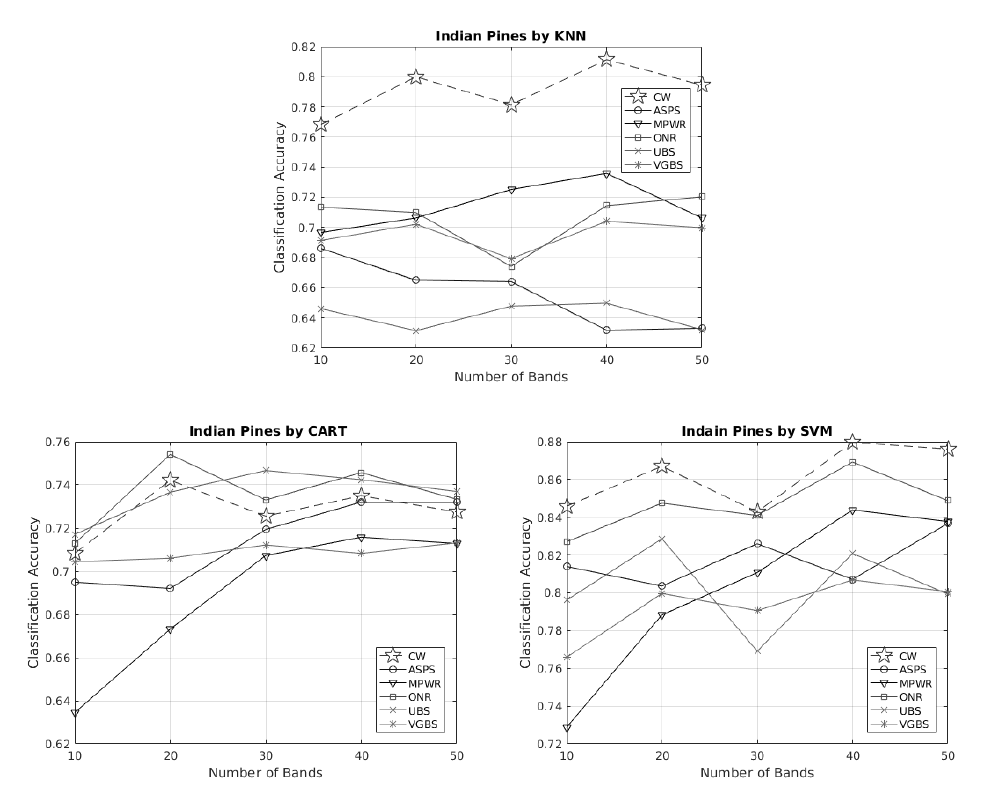
Figure 6. Overall accuracies for Indian pines image according to KNN, CART, and SVM classifiers.